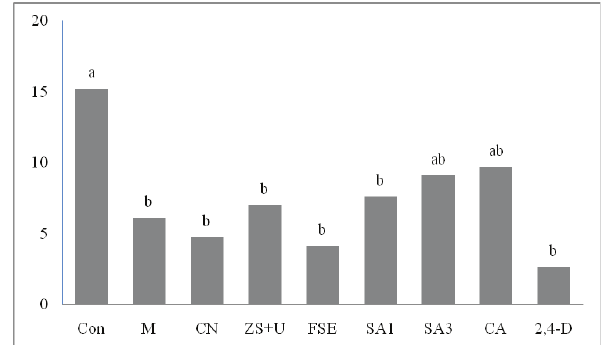
Figure 1: Effect of foliar-applied methanol (M), calcium nitrate (CN), zinc sulfate + urea (ZS+U), fermented sugarcane extract (FSE), sali- cylic acid 1 and 3 mM (SA1 and SA3), citric acid (CA), 2,4-dichloro- phenoxyacetic acid (2,4-D) and water (Con) on pre-harvest fruit drop (%) of ‘Thompson Navel’ orange. Differences in column headings denote statistically significant treatment effects (P<